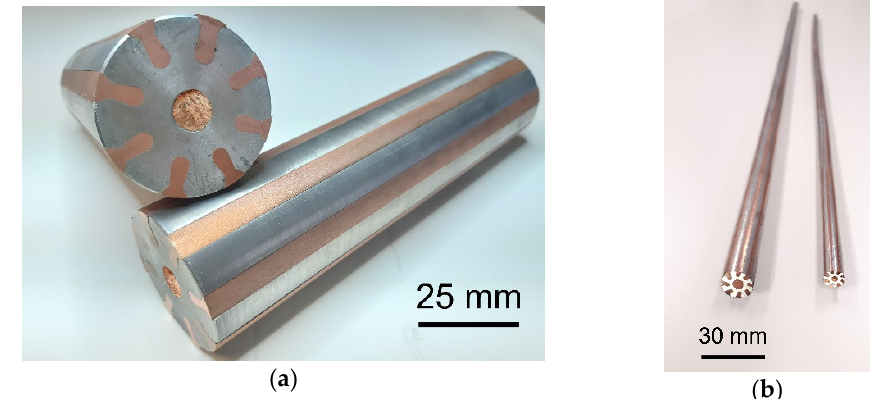
Figure 1. Al/Cu laminated workpiece (50 mm diameter) ( a ); swaged laminate (15 mm diameter) ( b ).